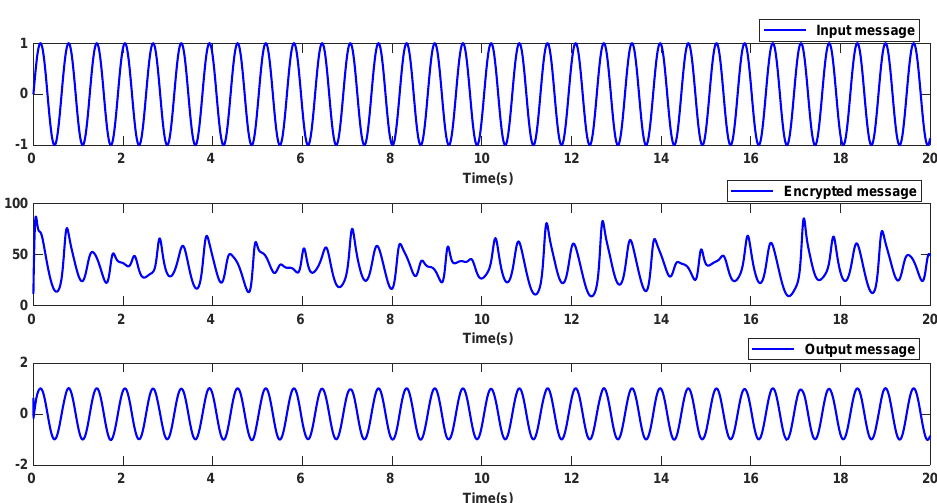
Figure 14. Example 2: Synchronization performance in a secure communication